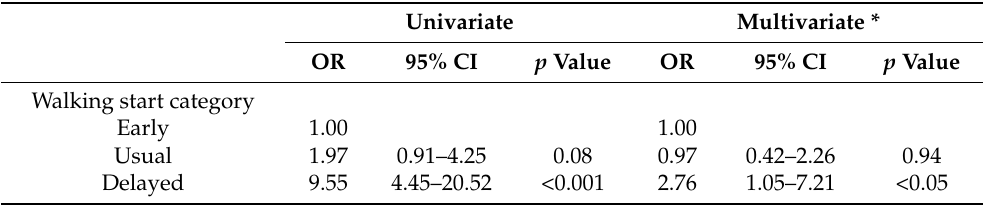
Table 5. Univariate and multivariate analyses for hospitalisation-associated disability by walking onset